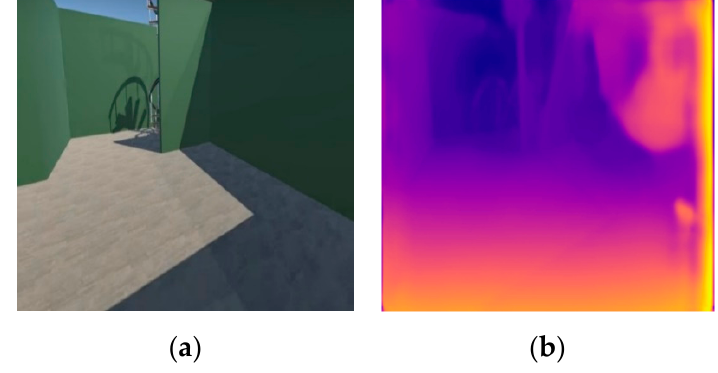
Figure 16. Depth image conversion: ( a ) original image, ( b ) depth